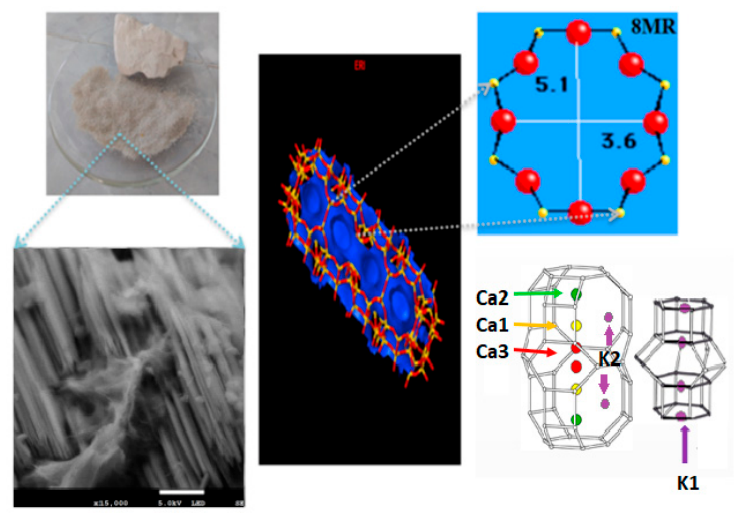
Figure 1. Erionite structure, International Zeolite Association (IZA).